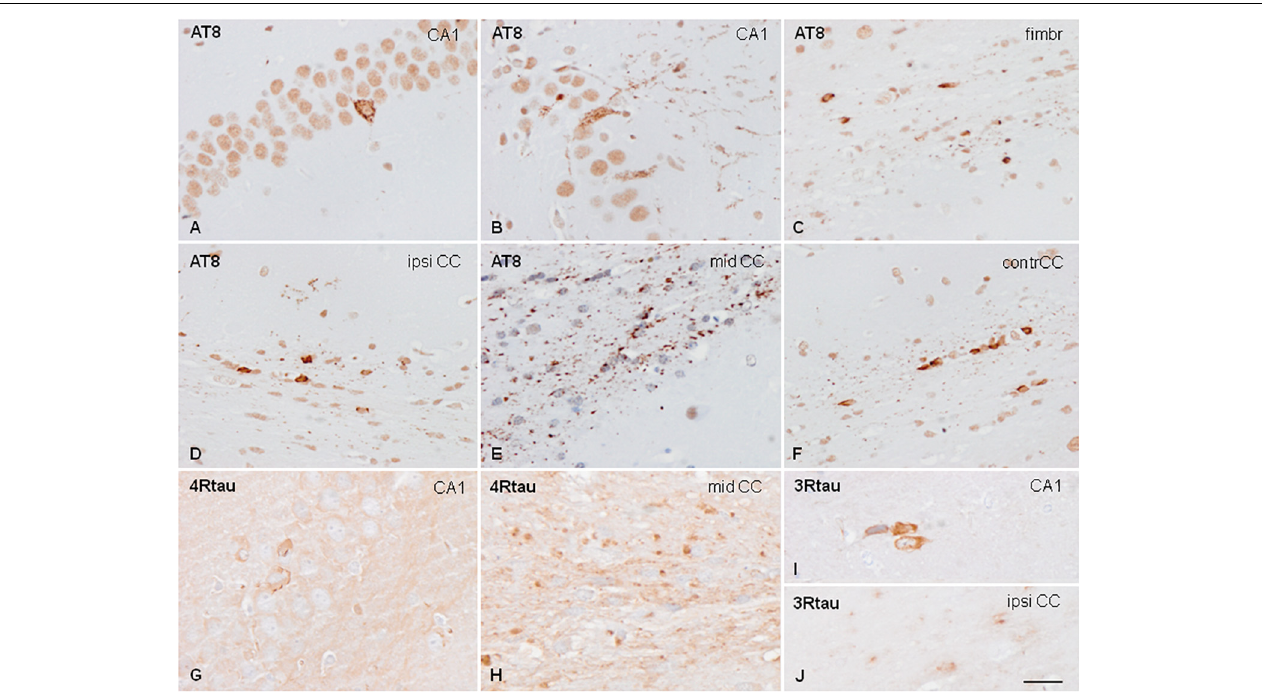
FIGURE 4 | Hyper-phosphorylated tau-containing cells and threads following unilateral intra-hippocampal injection of sarkosyl-insoluble fractions from PART into WT mice at the age of 7 months and killed at the age of 10 months (3 months survival) (A,C) ; 3 months and killed at the age of 10 months (C,D–F) ; and at the age of 12 months and killed at the age of 19 months (7 months survival) (G–J) . Tau deposits in neurons, independently of the survival time, show granular deposits in the cytoplasm, and occasional denser inclusions with no similarities with tangles (A,B) . Threads and coiled bodies are abundant in the fimbria and corpus callosum (C–F) . Individual neurons, threads and oligodendrocytes in inoculated mice are stained with anti-4Rtau (G,H) and anti-3Rtau (I,J) antibodies. Paraffin sections slightly counterstained with hematoxylin. CA1, region of the hippocampus; fimbr, fimbria; ipsi contr CC, ipsi- and contralateral corpus callosum; (A–F) , bar = 50 µ m; (G–J) , bar = 50 µ